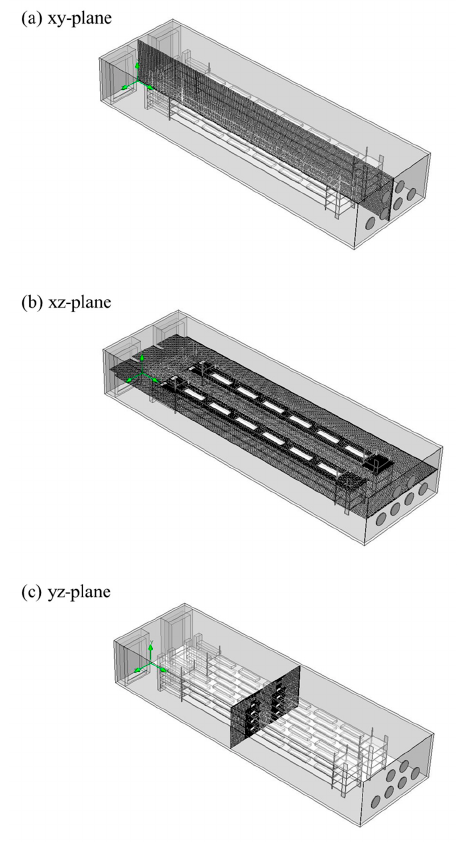
Figure 8. Mesh of layer house. ( a ) xy-plane; ( b ) xz-plane; ( c ) yz-plane.